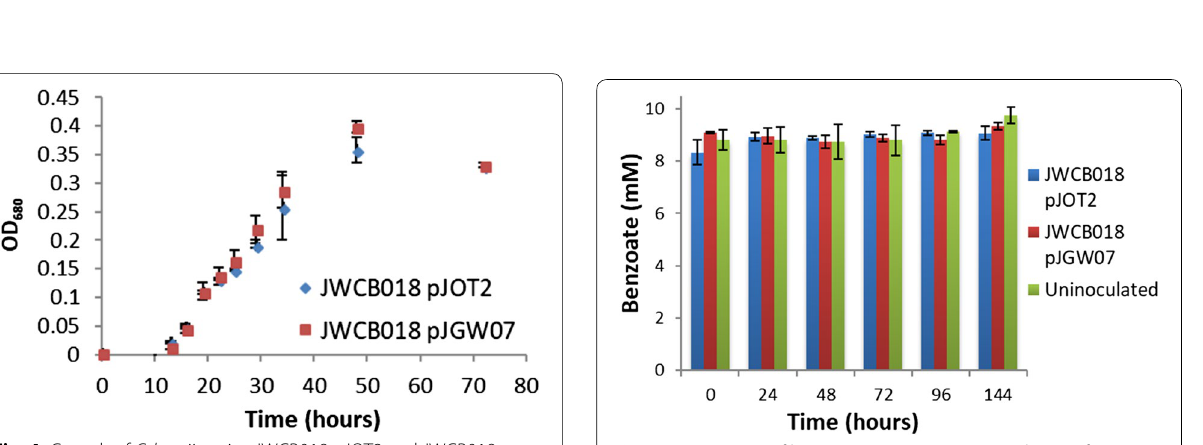
Fig. 5 Time course of benzoate concentration in cultures of C. bescii grown in defined medium containing 10 mM added sodium benzoate and 80 mM MOPS buffer. Benzoate concentrations do not decrease through 144 h of fermentation in the presence of C. bescii strain JWCB018 pJOT2. Error bars represent the standard deviation from analysis of 3 replicate